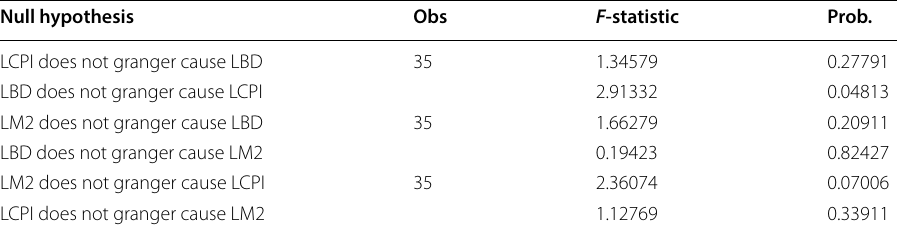
Table 6 Pairwise Granger causality tests Source : Output from Eviews